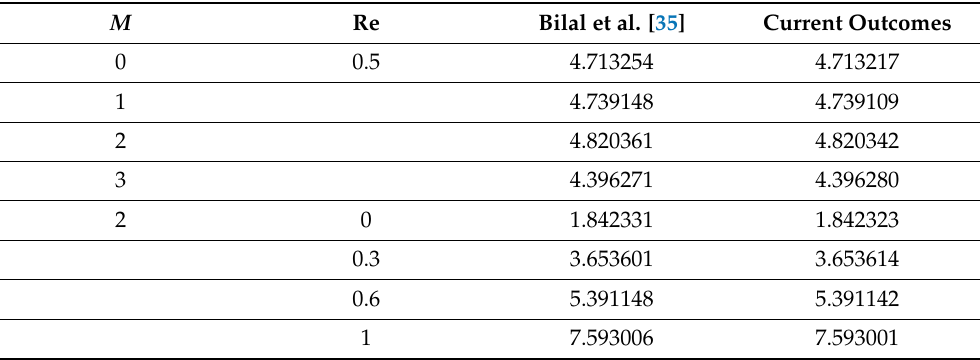
Table 2. Comparison of the present results with those that have been previously reported f (cid:48)(cid:48) ( 1 ) under specific conditions, such as, φ 1 = φ 2 =